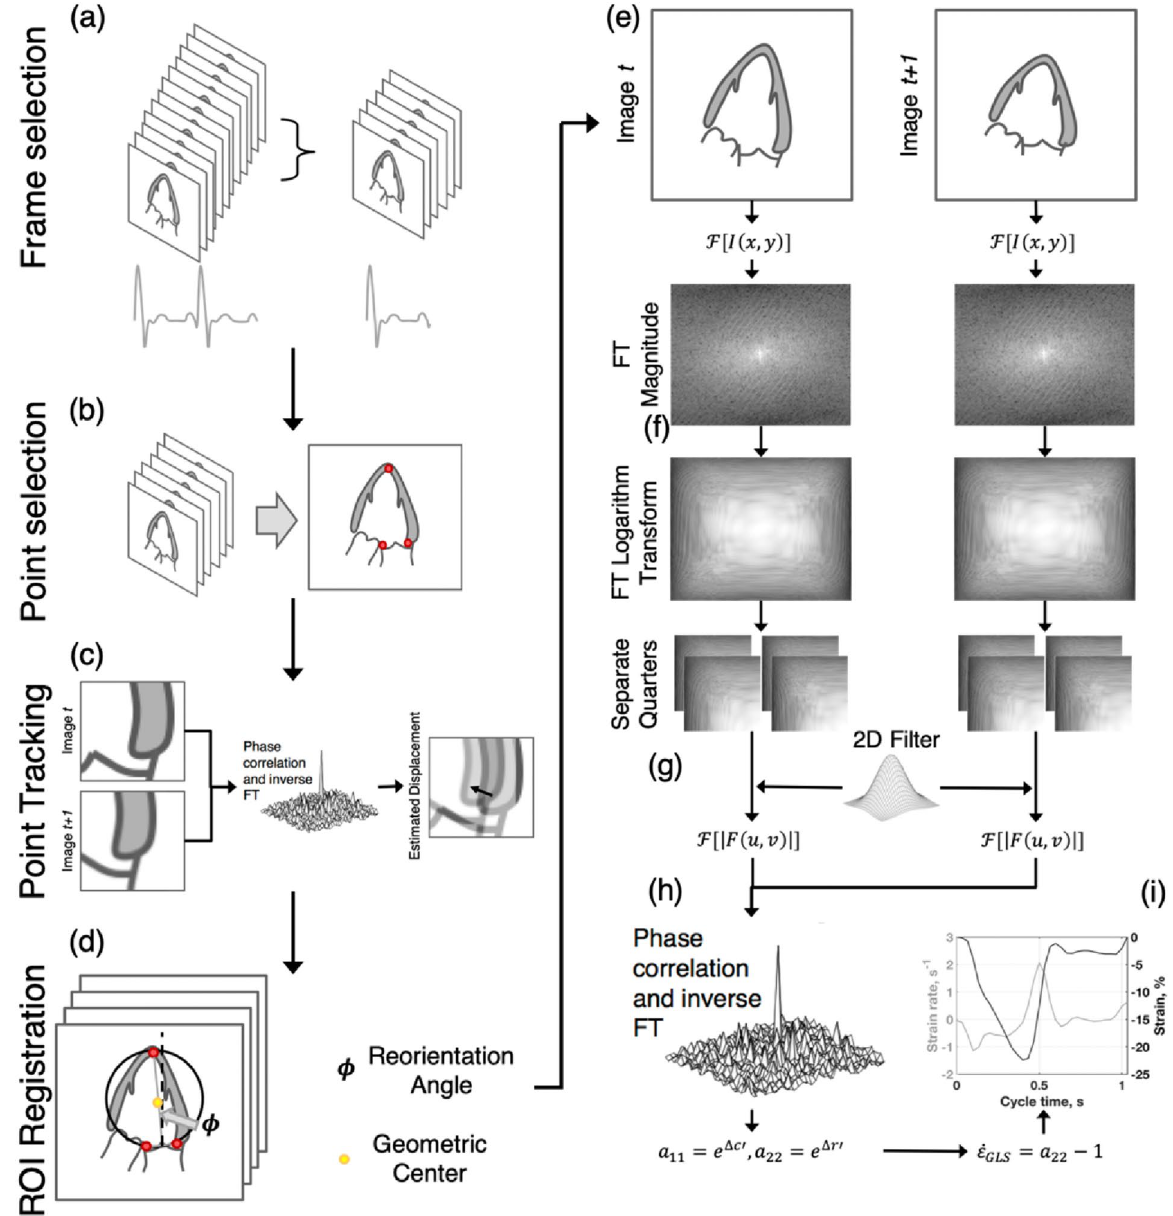
Figure 1. Illustration of the direct global longitudinal strain estimation algorithm. ( a ) Frames for a single beat are selected from an input echocardiogram. ( b ) User inputs for the apex and annulus positions from a reference frame are provided. ( c ) The inputs are tracked temporally. ( d ) Frame co-registration is performed. ( e ) The LV is cropped from each frame, and these sub-images are Fourier-transformed. ( f ) The FT magnitude is calculated, interpolated onto a logarithm-basis, and separated into four sub-images. ( g ) Each sub-image is Fourier-transformed and convolved with a phase filter. ( h ) Ensemble phase correlation is performed, producing a correlation plane with a peak shifted from the plane center. This shift corresponds to a frame pair strain rate. ( i ) Strain is computed by temporally integrating the strain rate